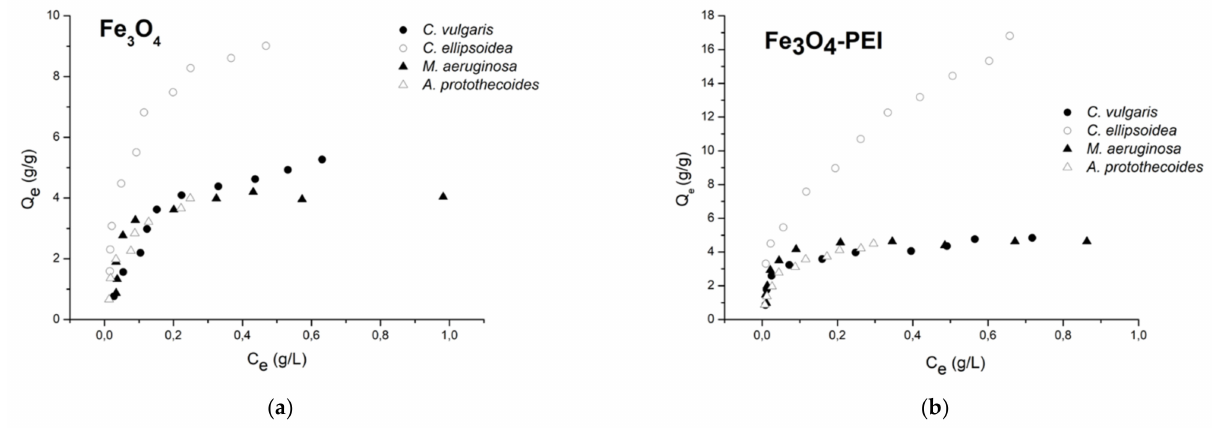
Figure 9. Adsorption isotherms for the sorption systems of tested algae and ( a ) non-coated magnetite and ( b ) PEI-coated magnetite prepared at 20 ◦ C, pH 7. Table 3. Adsorption isotherm parameters for the studied algae-NPs species at 25 ◦ C.